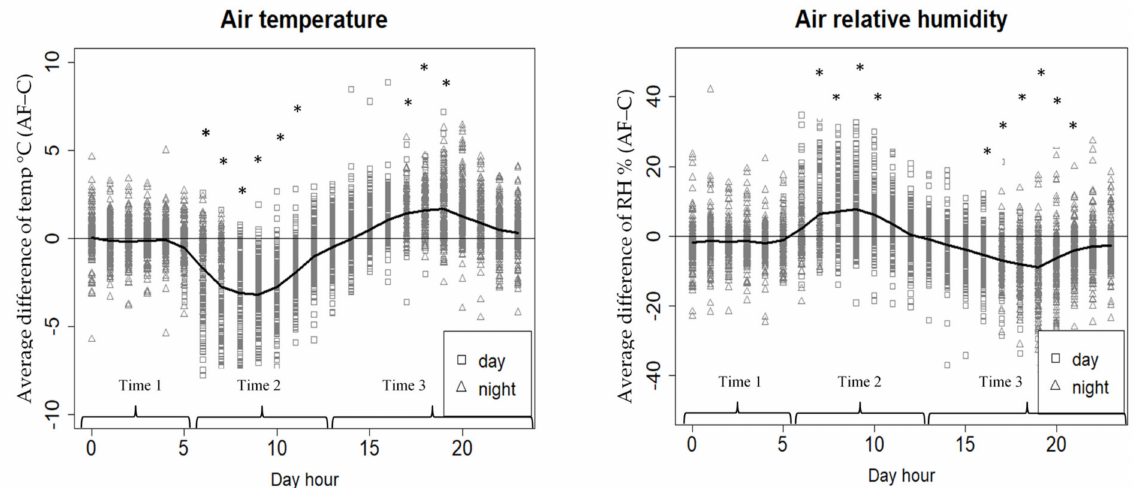
Figure 2. Hourly dynamics of air temperature (temp; left ) and relative humidity (RH; right ) recorded in C and AF treatments expressed as AF and C difference: temp.AF-temp.C ( ◦ C) and RH.AF-RH.C (%) for each hour of the day during the 2016–17 wheat growing season, from sowing to harvesting. Above the x axis, day length is divided into 3 intervals: Time1 = 12 pm–5 am, Time2 = 6 am–12 am, Time3 = 1 pm–11 pm. For each hour of the day, asterisks indicate a significant difference between values recorded in C and AF treatments ( p ≤ 0.05).